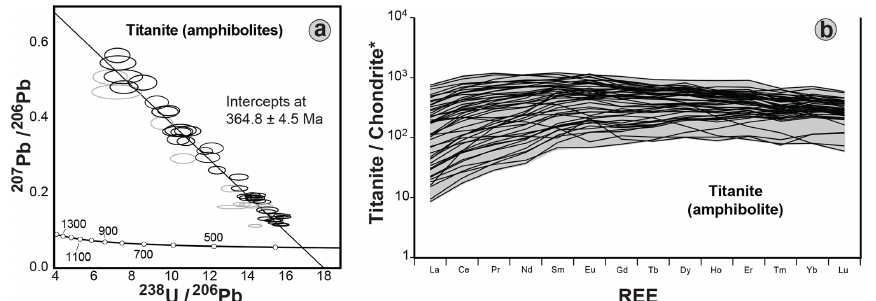
Figure 7. (a) Tera–Wasserburg diagram showing distribution of analyzed titanite ( n = 51) from Sobrado amphibolite (JBP-71-21). The rejected analyses are represented by gray ellipses. The ellipses represent the 207 Pb / 206 Pb and 238 U / 206 Pb errors ( ± 2 σ ). (b) Chondrite- normalized REE patterns for the same titanite.